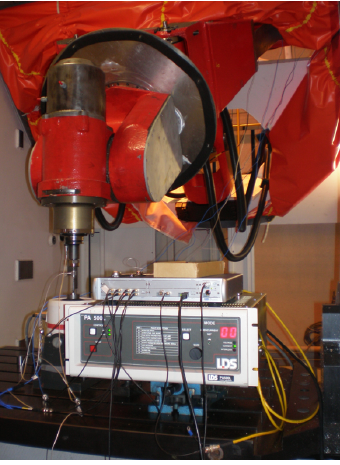
Figure 13. First natural frequency measurement.